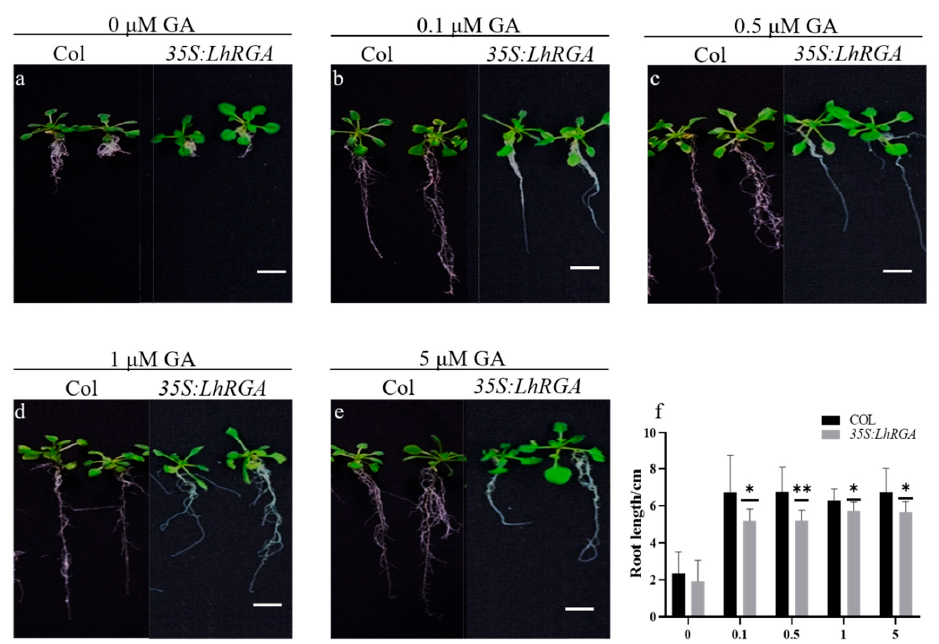
Figure 8. Morphological phenotypes of Arabidopsis overexpressing LhRGA after GA treatment. ( a – e ) Phenotypes of 15-day-old wild-type and transgenic plants treated with different concentrations of GA. Scale bar = 1 cm. ( f ) Measurement of root length in the wild-type and transgenic lines ( a – e ). Error bars: ± SD. * p < 0.05; ** p < 0.01.